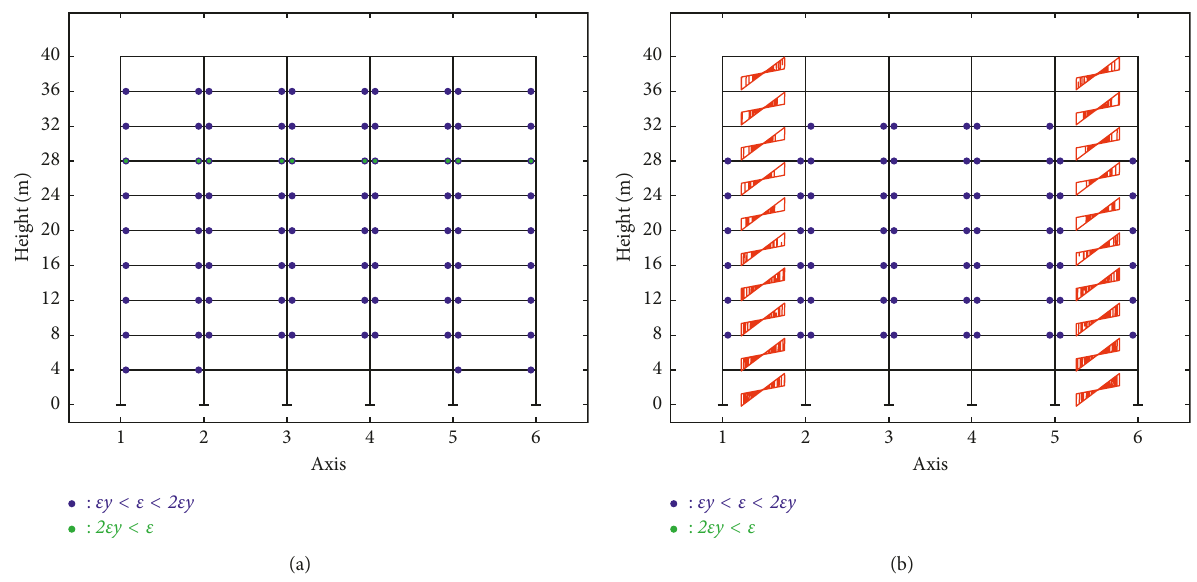
Figure 21: Damage degree of integral structure component: (a) uncontrolled structure; (b) controlled structure ( η